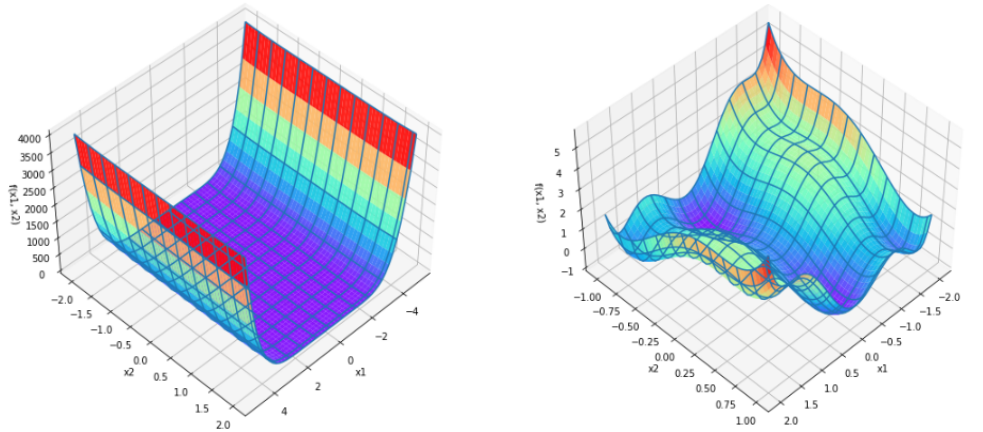
Figure 12. Surface plot of the SIX-HUMP CAMEL